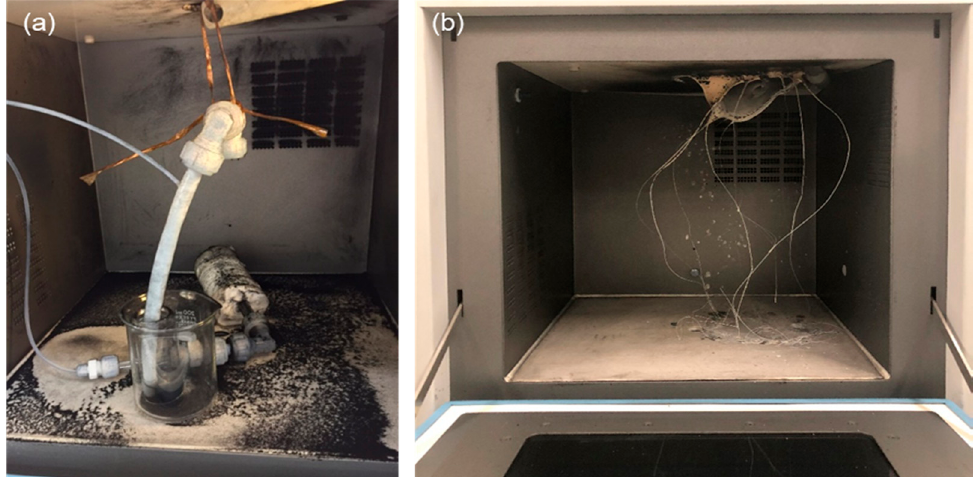
Figure 8. Photographs showing the results of the accidents that occurred in a 2.45-GHz multi-mode applicator domestic microwave device: ( a ) fire-caused accident during the dehydrogenation of methylcyclohexane using Pt/AC solid catalyst particles; ( b ) soot formed after the fire that burned the resin that adhered to the applicator.